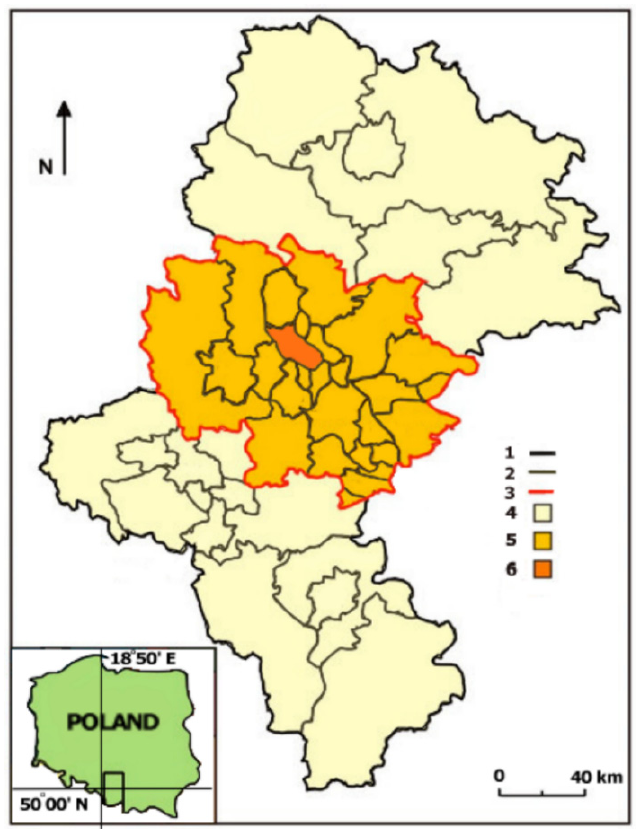
Figure 1. Location of the studied city (Sourced by authors). Explanations: 1—Silesian province boundary; 2—county and commune boundaries; 3—Katowice conurbation boundaries; 4—area of the Silesian province outside the Katowice conurbation; 5—area of the Katowice conurbation; 6—city of Bytom discussed in the